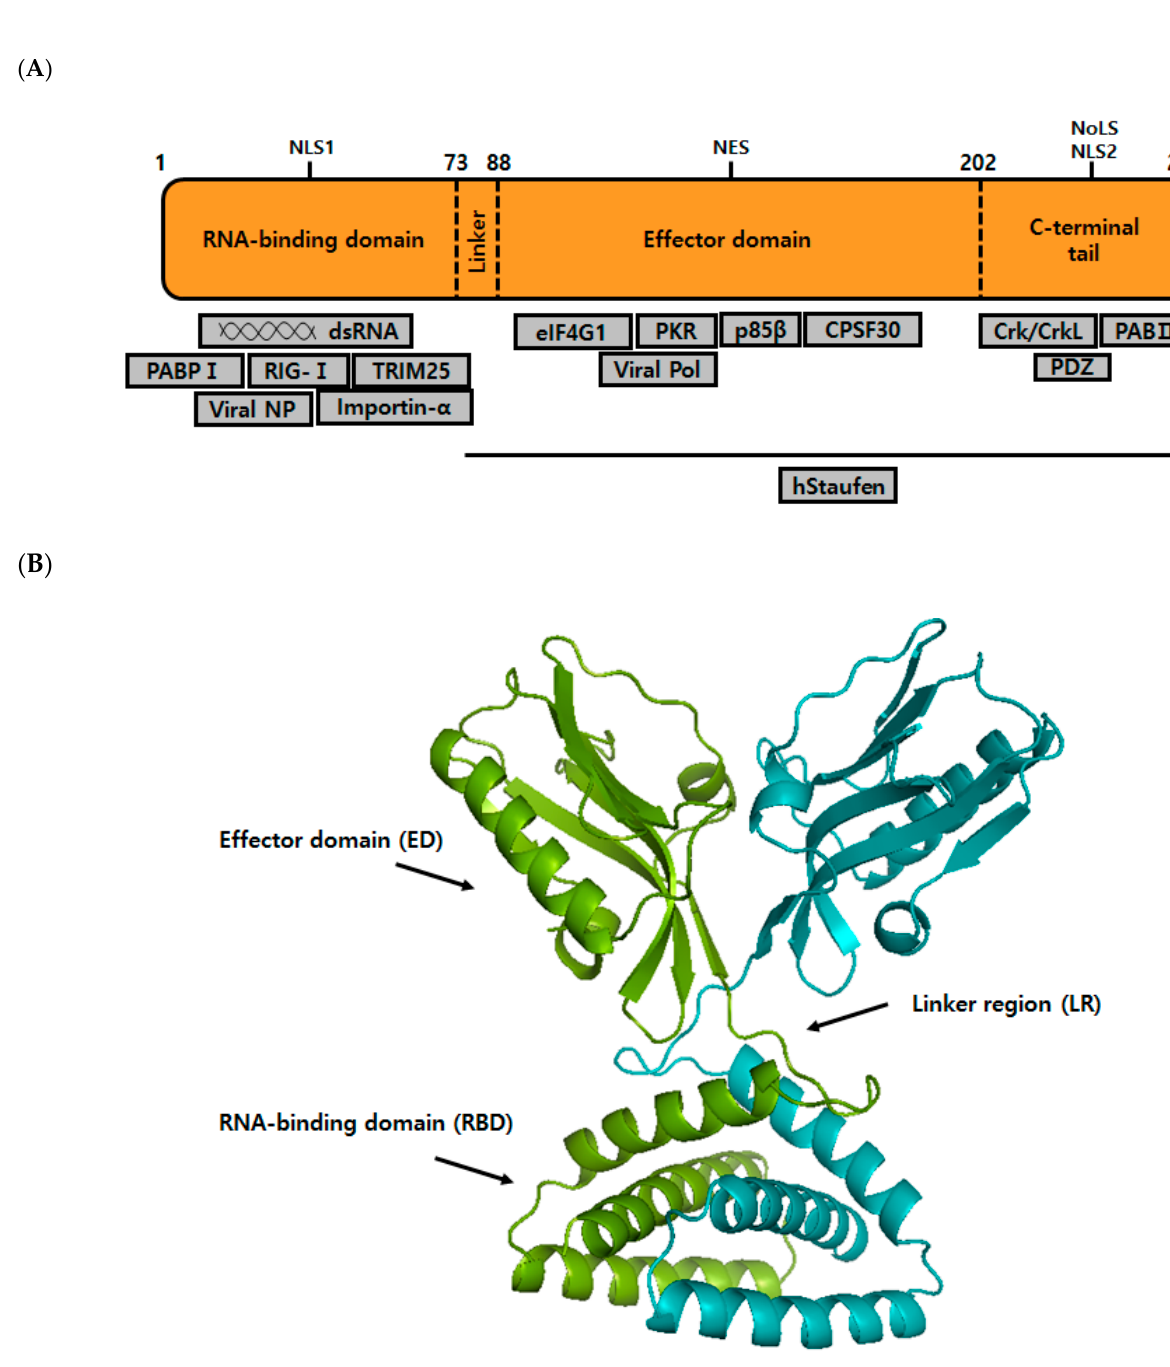
Figure 1. Structural analyses of NS1. ( A ) Schematic representation of the full-length NS1 domain and of interacting proteins. NS1 consists of an RNA-binding domain (RBD), a linker region (LR), an effector domain (ED), and a C -terminal tail (CTT). RBD binds to dsRNA to inhibit the interferon (INF) induction, whereas the C -terminal ED region mediates interactions with several host cellular proteins. ( B ) NS1 dimer adapted from the X-ray structure of H6N6 NS1 (PDB ID: 4OPA), showing interactions between the two RBD.